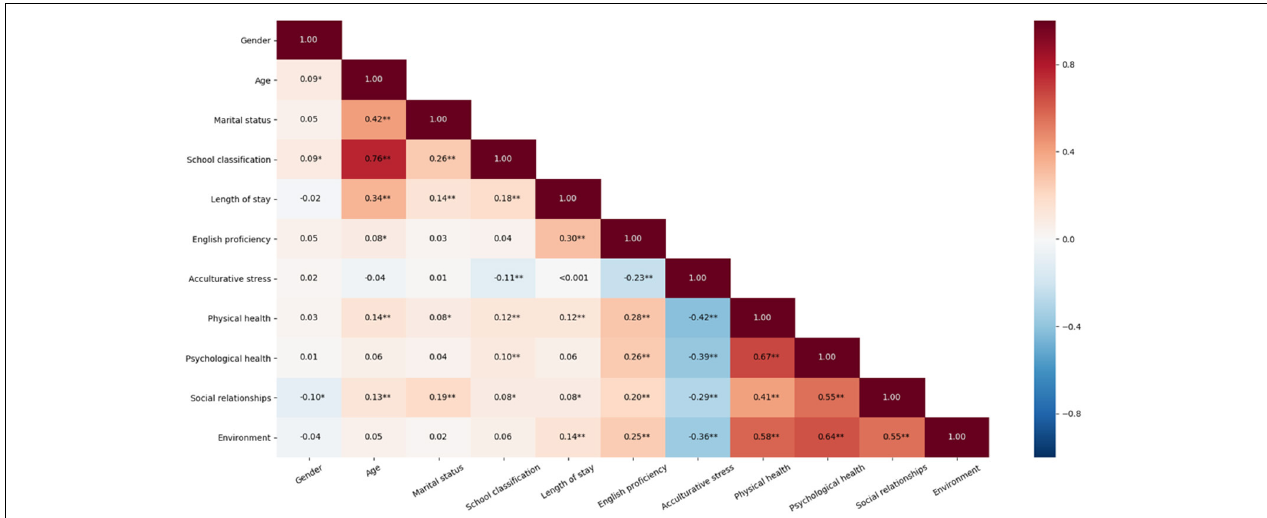
FIGURE 1 | Correlations of key study variables ( N = 751). ∗ Red colors represent positive correlations, while blue colors denote negative correlations. The darker or more saturated the color, the stronger the relationship. Two asterisks (i.e., ∗∗ ) are used to highlight p -values that are less than 0.05, whereas one asterisk (i.e., ∗ ) is used to refer to less than 0.1 p